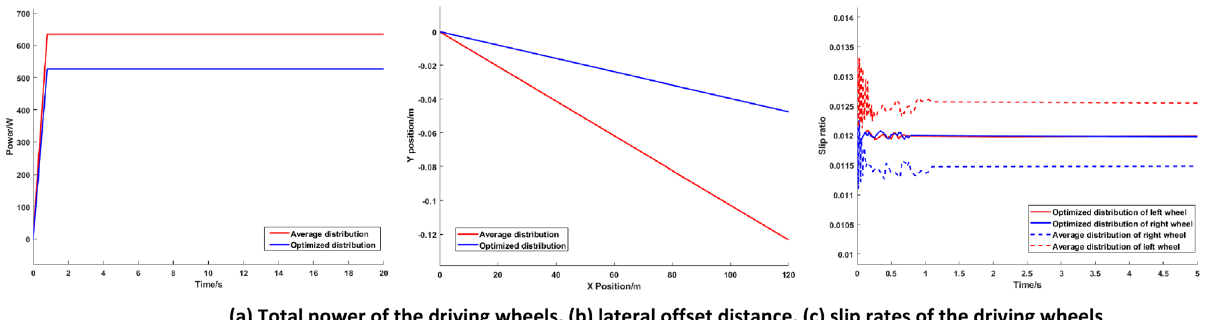
Figure 6. Simulation comparison diagrams of low load